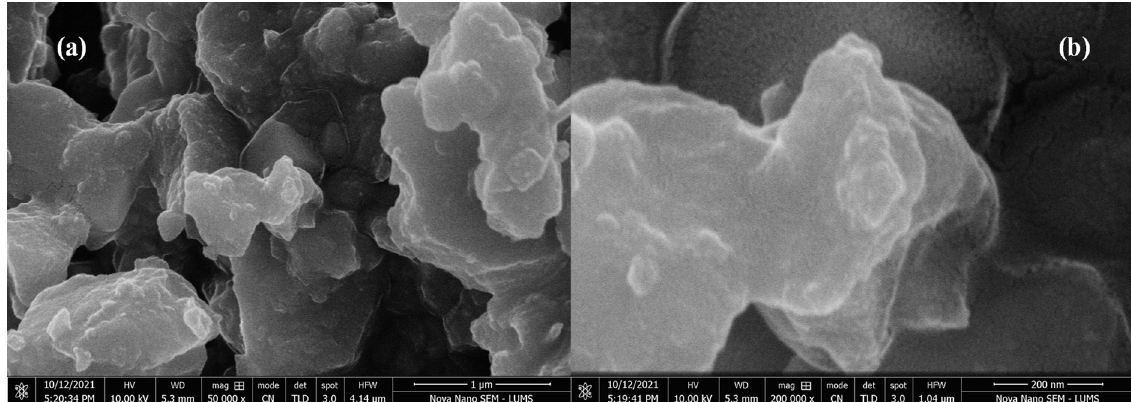
Figure 5. SEM micrographs of Mn NPs at 1 µm ( a ), 200 nm ( b ).